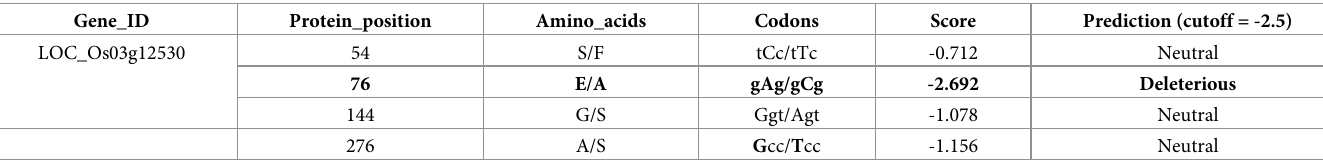
Table 5. Functional effect prediction for the amino acid changes located in the candidate OsMTP8 gene. Neutral or deleterious effect was predicted based on the score estimated using PROVEAN tool (http://provean.jcvi.org/about.php).